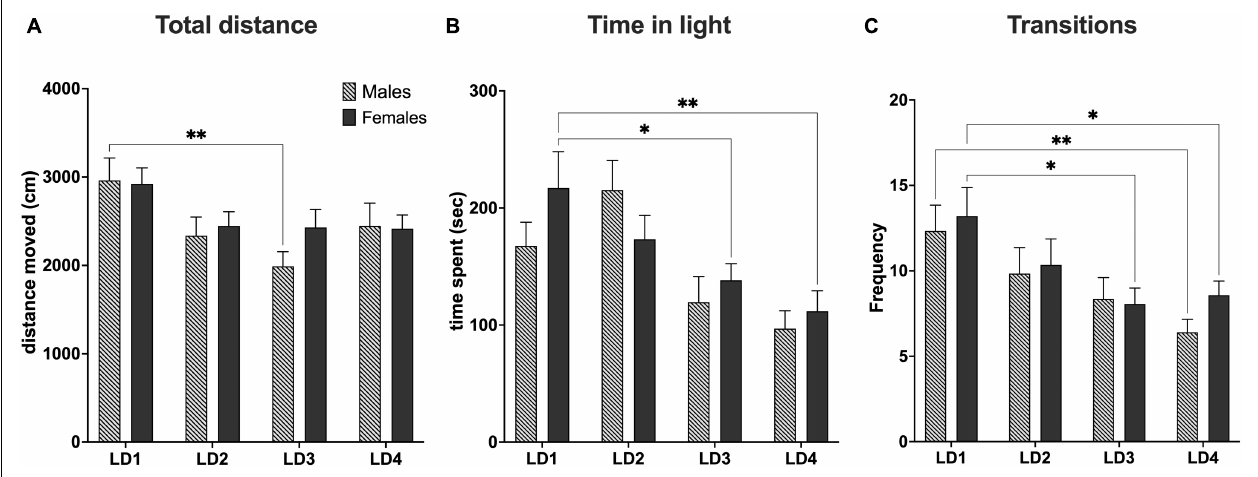
FIGURE 6 | Behavioral data from light-dark test. (A) Total distance traveled during the light-dark test (10 min). (B) Total time spent in the light compartment (C) . Total amount of transitions between the light and dark compartment. LD1 (light-dark test performed before surgery; males, n = 15; females, n = 15). LD2 (light-dark test 1 day after first habituation day; males, n = 19; females, n = 20). LD3 (light-dark test performed after last habituation day; males, n = 17; females, n = 19). LD4 (light-dark test performed 14 days after habituation; males, n = 17; females, n = 17). ∗ P < 0.05; ∗∗ P < 0.01. Data are presented as mean ± SEM.